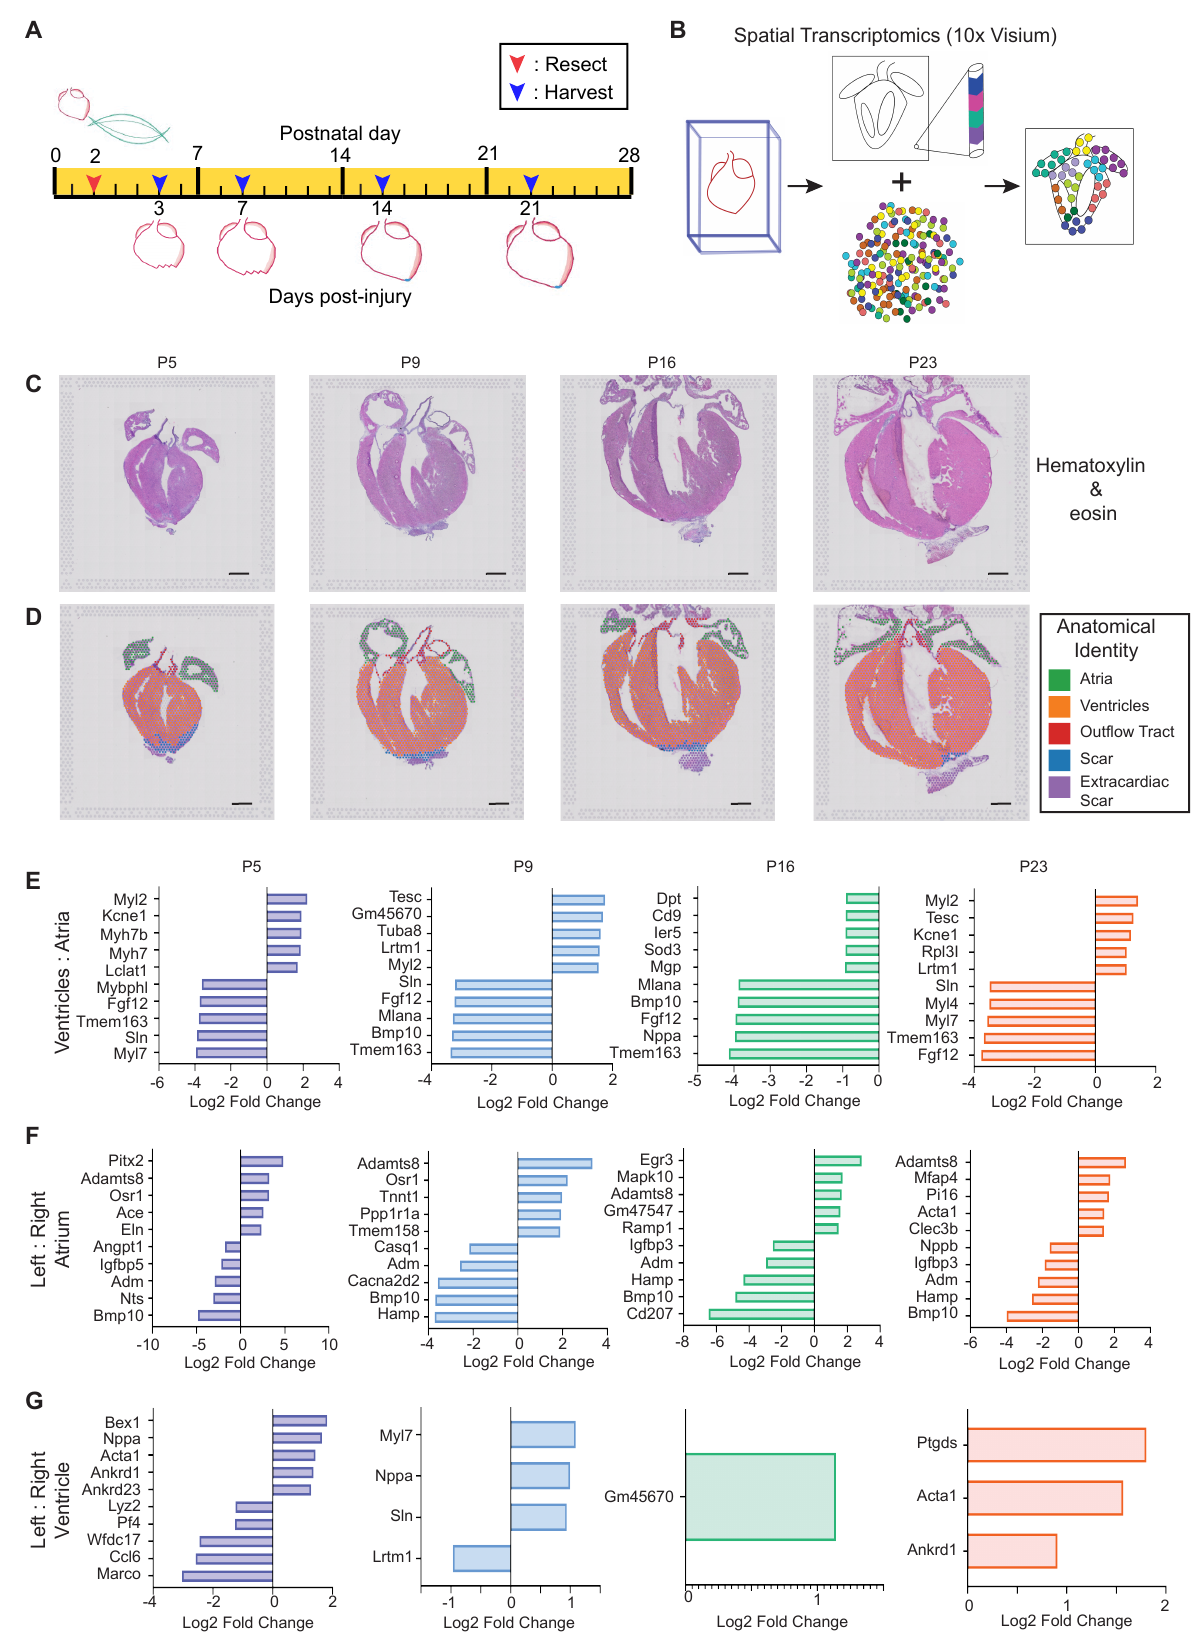
Figure 2. Spatially and temporally resolved transcriptional map of the regenerating neonatal mouse heart. ( A ) Schematic representation of the experimental timeline of apical resection (R) and tissue harvest